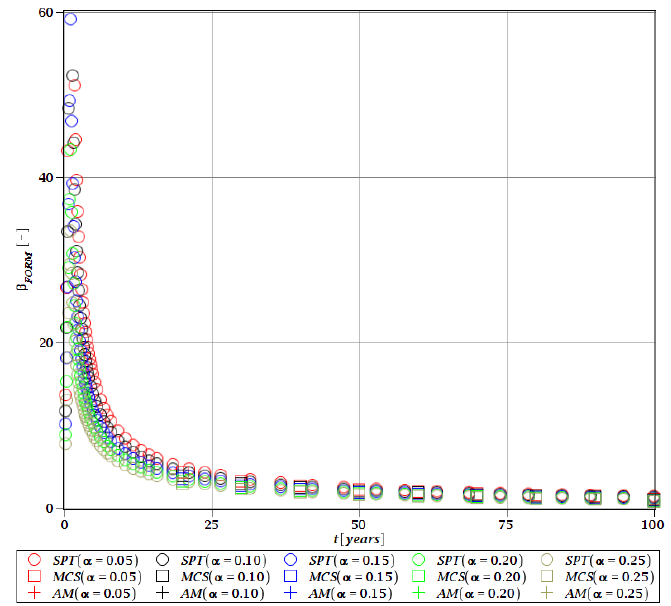
Figure 22. Reliability index of the corrugated I-beam for different types of weights according to FORM — deflection (SLS), the second-order polynomial.